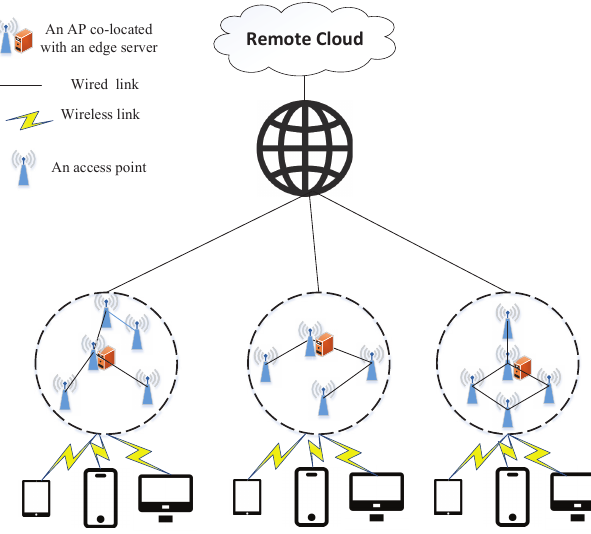
Figure 1. Mobile edge computing